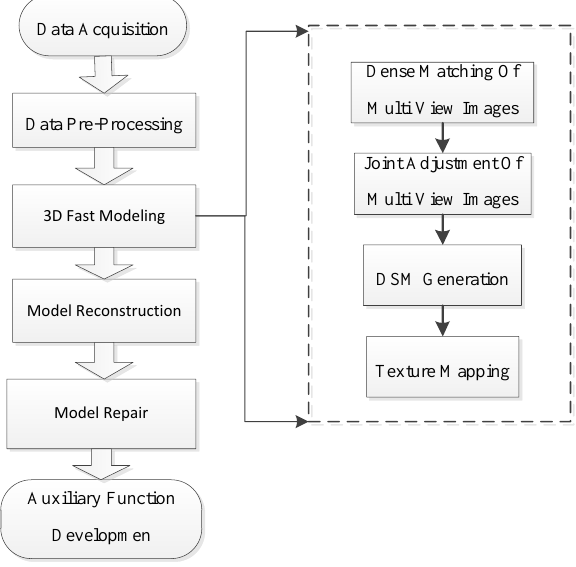
Figure 1. Key production process of real scene 3D